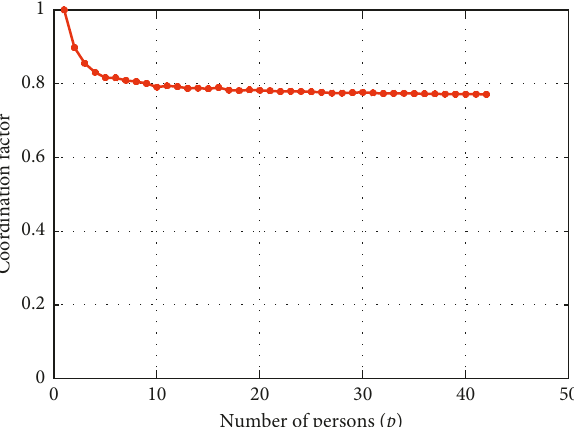
Figure 14: Mean value of coordination factors with different numbers of persons for the reference configuration at 1.8